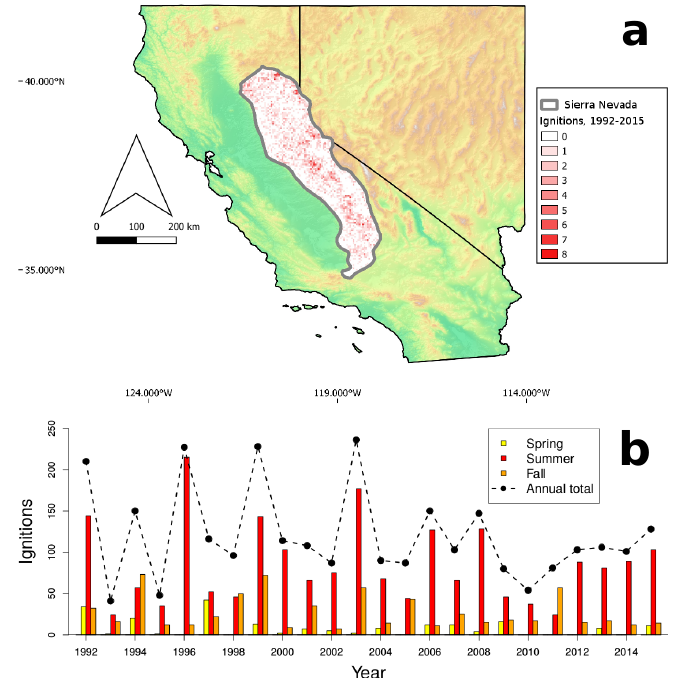
Figure 1. Study area map of the Sierra Nevada region, including the number of fire ignitions in each 4 km grid cell from 1992 to 2015 (Panel a ), and a barplot illustrating the timeseries of wildfire ignitions in spring, summer, and fall from 1992 to 2015 (Panel b ). The black line in Panel ( b ) illustrates total wildfire ignitions in each